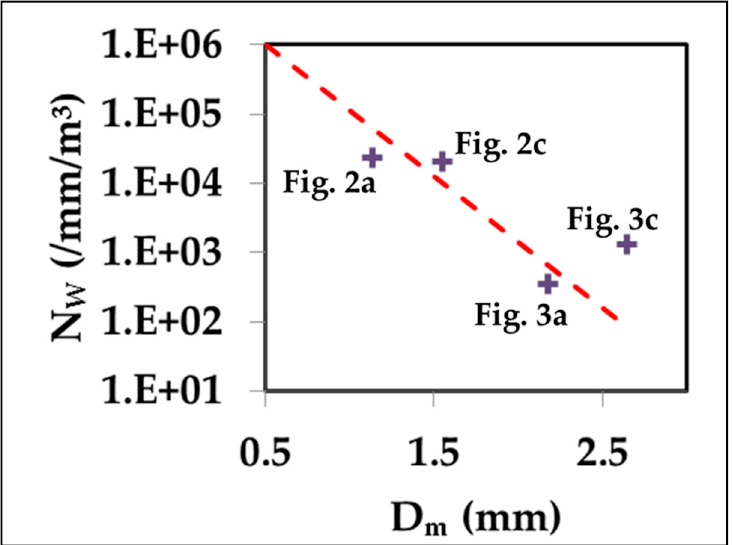
Figure 4. N W versus D m from 1 or 3 min DSDs corresponding to Figures 2a,c and 3a,c, as marked. For stratiform rain (more steady), 3 min DSDs were used, and for convective rain (faster variability), 1 min DSDs were used.